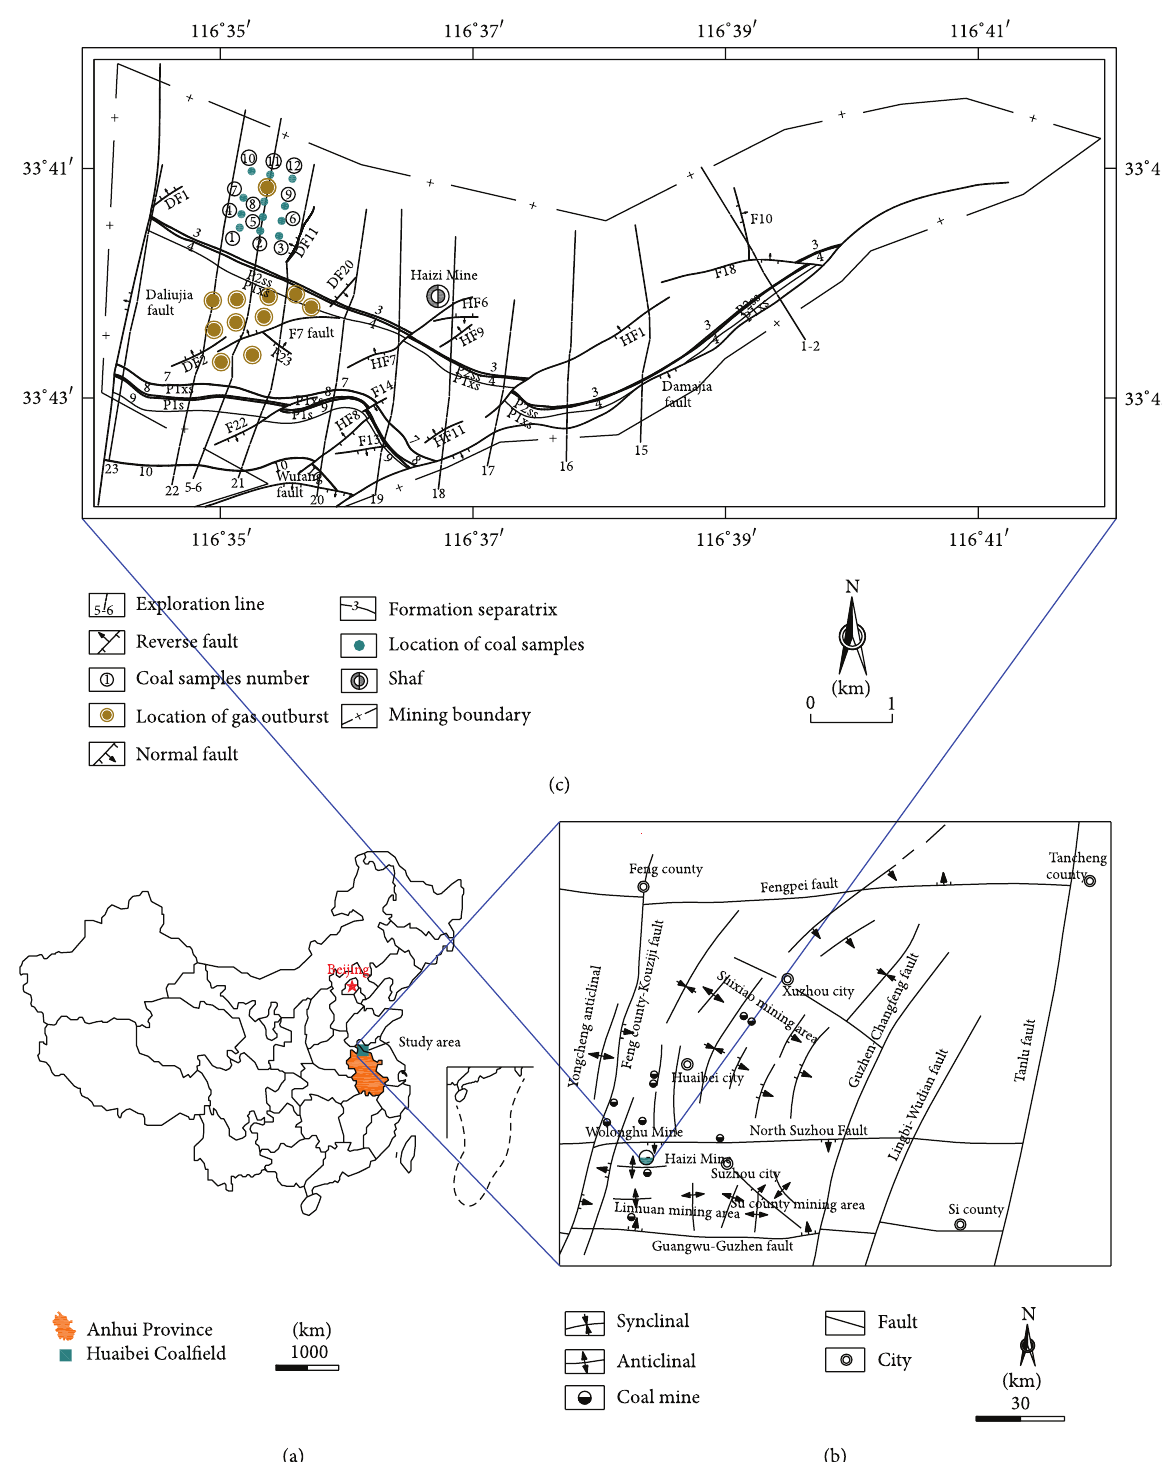
Figure 1: Map showing study area in China (a), geologic structure of the Huaibei Coalfield (b), and data locations of the coals from Haizi Mine